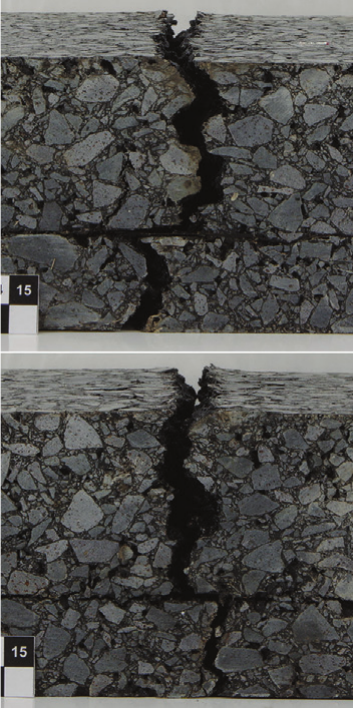
Fig. 1. Middle sections of beams after monotonic (strength)